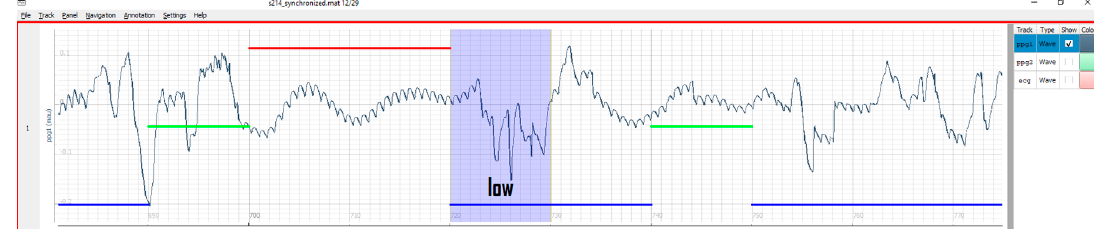
Figure 4. Example PPG signal in partition mode: one can label activities, motion artefacts, and other regions of interest. Figure 5. Example PPG signal in epoch mode: blue, green, and red color bars stand for different signal quality levels assigned to 10 s segments.